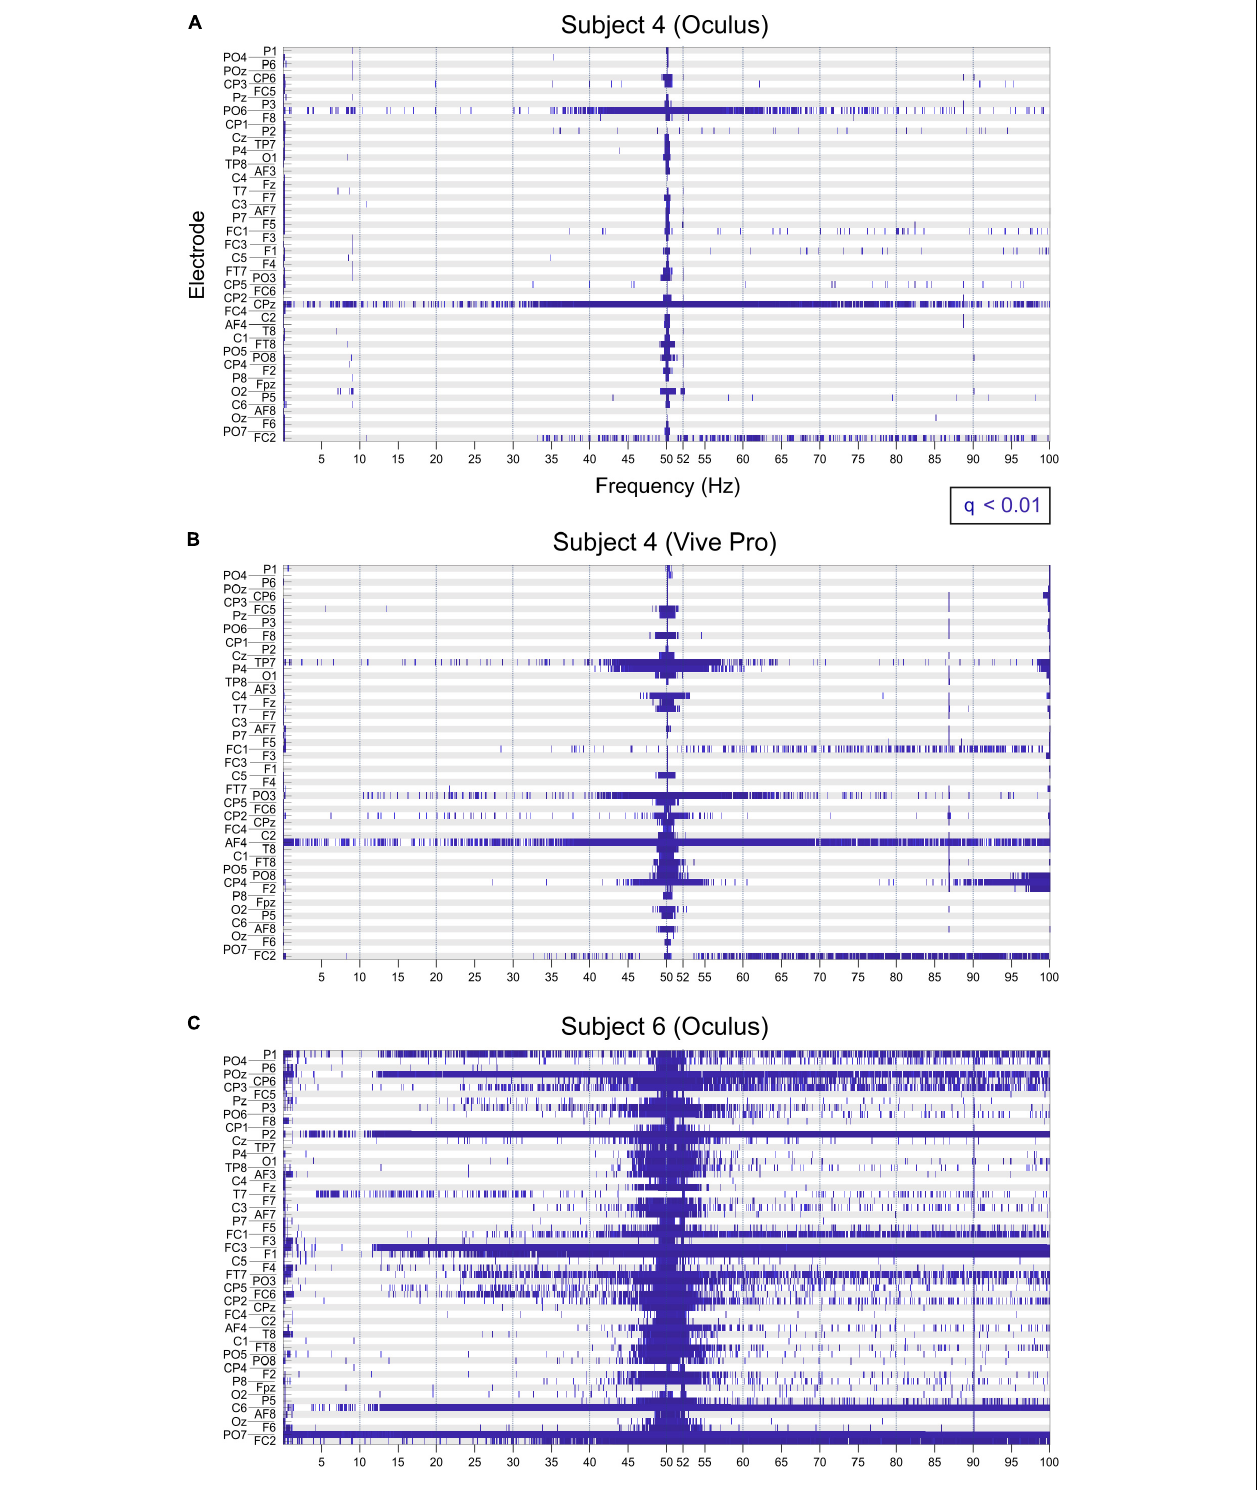
FIGURE 5 | Significant differences ( q < 0.01) in spectral power between VR and no-VR conditions indicated in blue, for each frequency bin ( x -axis) for all electrodes ( y -axis). Significant differences for subject for using the Oculus (A) and the Vive Pro (B) . At 50 Hz, all electrodes showed significant different power values. For some electrodes, this effect was also present at 52 and 87 Hz. (C) Consistent significant differences can also be observed at 50 and 90 Hz.